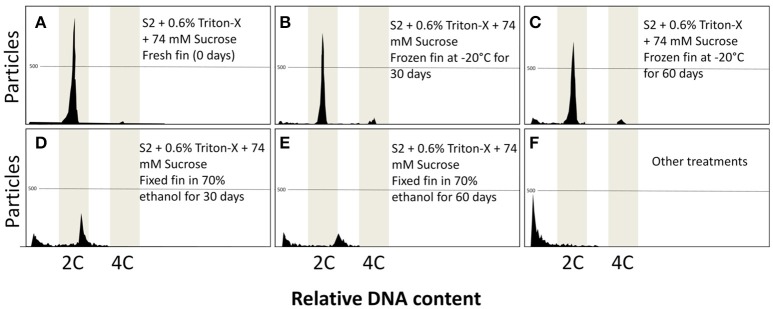
Flow cytometric charts of fin samples and isolated nuclei preserved using various procedures at 0, 30, and 60 days of storage. Frozen fins at −20°C gave the best results and storage at 30 days (B) and 60 days (C) did not differ from fresh samples (0 days) (A). Fixation of fin in 70% ethanol gave peaks with low amount of particles and peak deviation at 30 days (D) and 60 days (E). Other treatments did not generate any data (F).